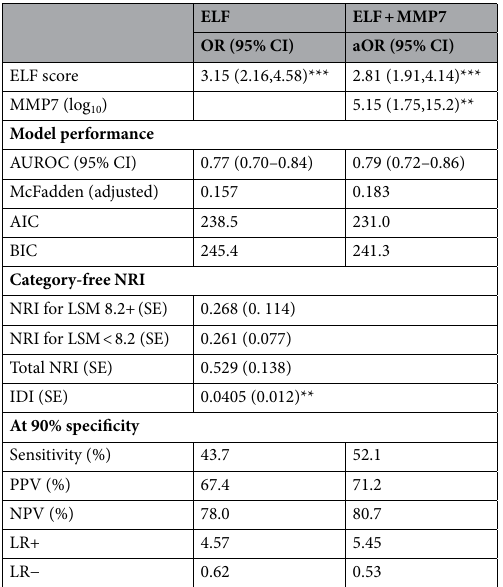
Table 3. Performance of models with ELF and ELF + MMP7 for the prediction of LSM > 8.2. Logistic regression. AUROC: area under the receiver operating curve, AIC: Akaike information criterion, BIC: Bayesian information criterion, NRI: net reclassification improvement, IDI: integrated discrimination improvement, PPV: positive predictive value, NPV: negative predictive value, LR+: positive likelihood ratio, LR−: negative likelihood ratio. **p < 0.01, ***p <